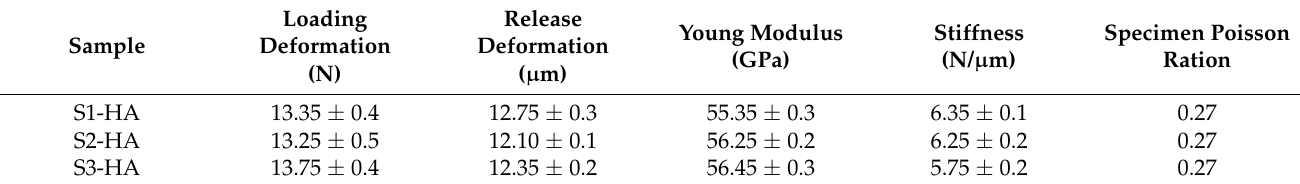
Table 5. Micro-indentation results *.